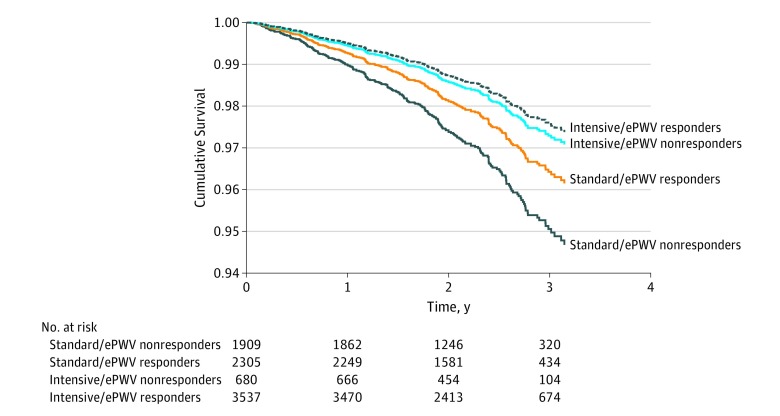
Combined Effect of Treatment Allocation and Response of Estimated Pulse Wave Velocity (ePWV) to Treatment on All-Cause DeathTime zero is 12 months after randomization.